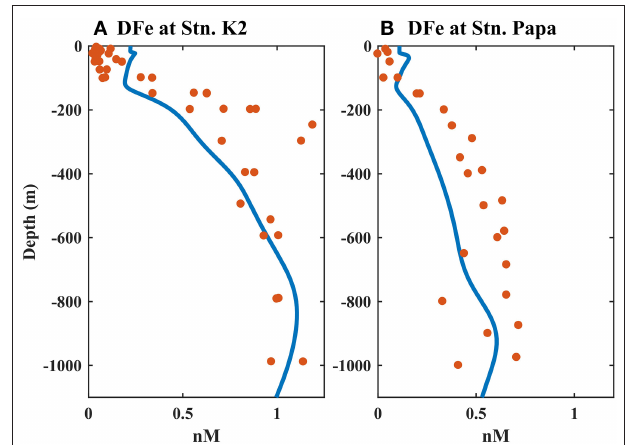
FIGURE 3 | Comparison of the modeled distributions of the dissolved iron (DFe) concentration in the summer at (A) Stn. K2 and (B) Stn. Papa, with observations from Tagliabue et al. (2012), Schallenberg et al. (2015), and Nishioka et al. (2020). The blue solid line is the model result, and the solid circles are the